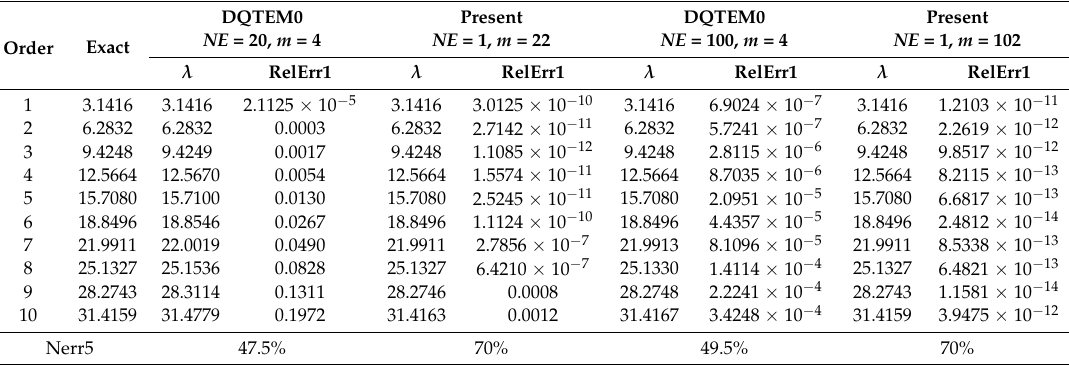
Table 8. Frequency comparisons of beam with same deflection degrees for both